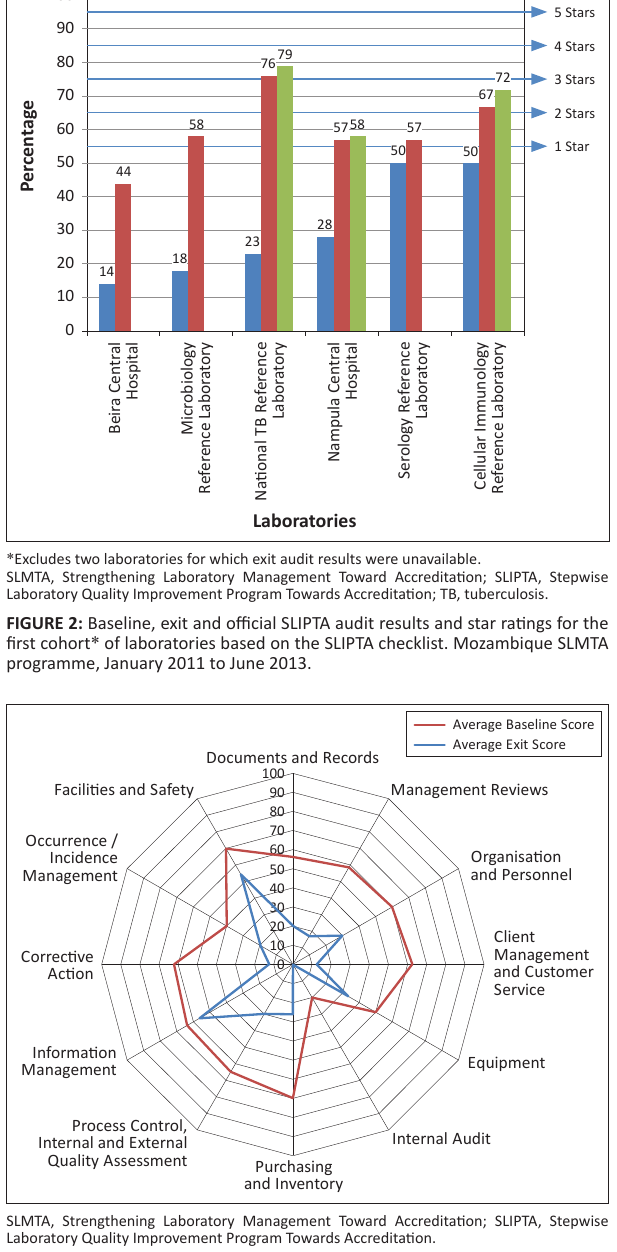
FIGURE 3: Average performance of six laboratories enrolled in first SLMTA cohort in Mozambique across the 12 sections of the SLIPTA checklist before and after SLMTA implementation as measured by baseline and exit audits (January 2011 to March